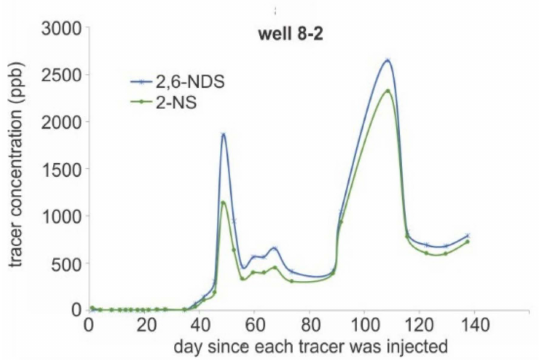
Figure 11. Returns of the tracers 2,6-nds and 2-ns, which were injected into well